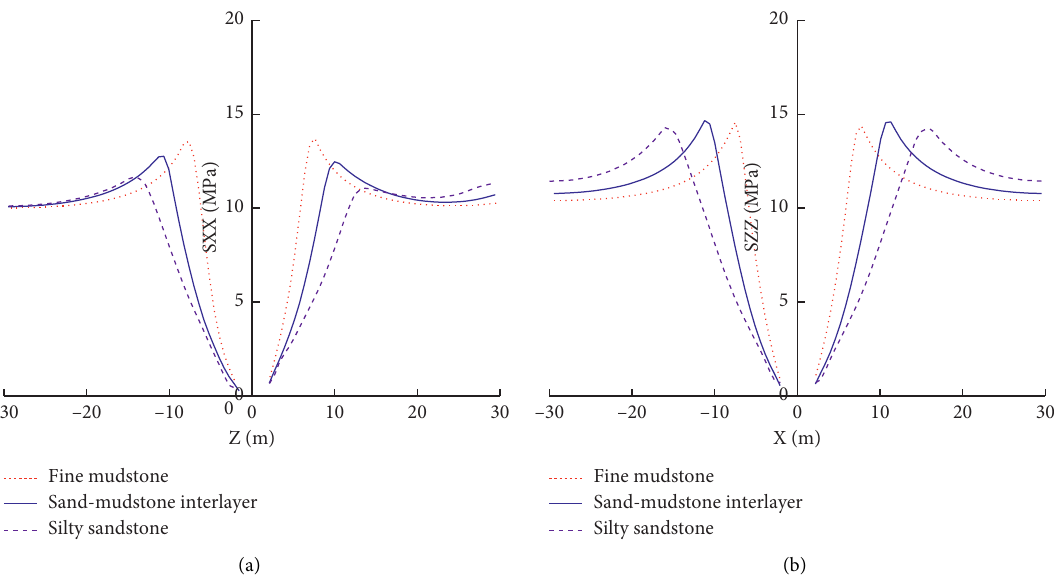
Figure 8: Distribution law of stress on monitoring line under different lithology conditions. (a) Vertical survey line. (b) Horizontal survey line.